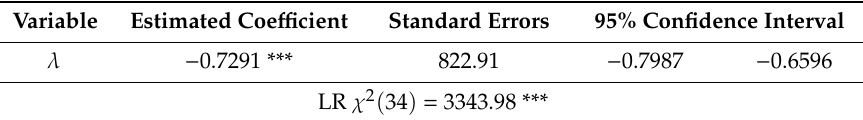
Table 2. Estimation result of Box–Cox